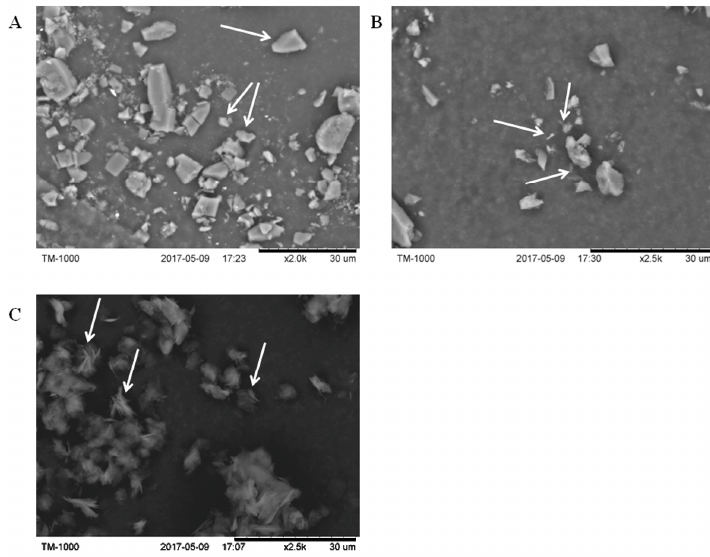
Figure 1. Scanning electron microscopy (SEM) images of β -cyclodextrin ( β -CD)-ellagic acid microspheres. ( A ) β -CD; ( B ) ellagic acid; ( C ) β -CD-ellagic acid microspheres.